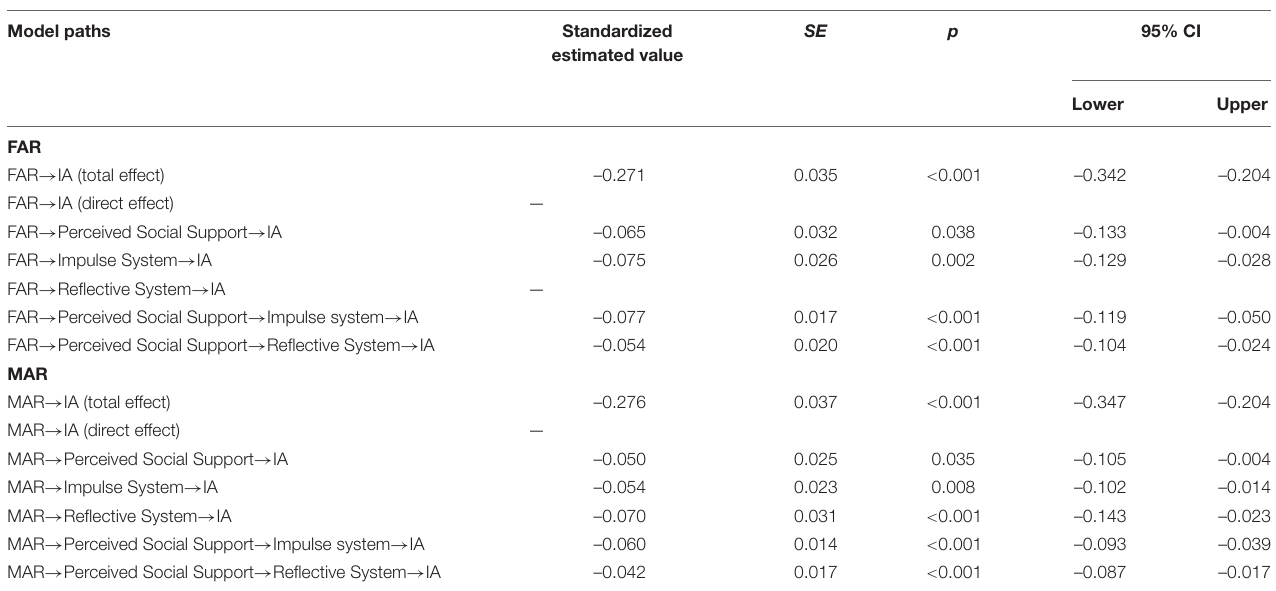
FIGURE 3 | Correction model. TABLE 4 | Total, direct, and indirect effects among the variables ( N =